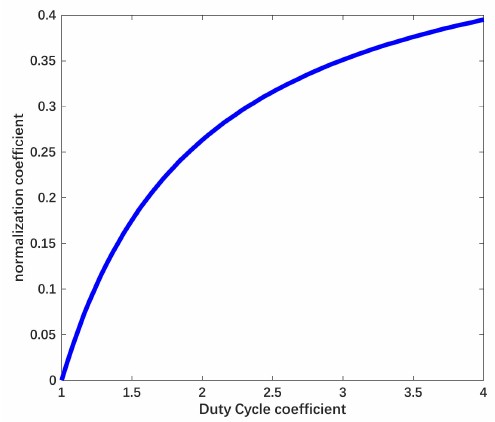
Figure 8. The variation of total electrostatic force with linearly increasing deposited charge in time domain: ( a ) Total electrostatic force under different forms of actuation and the coefficient of duty cycle is set as 2; ( b ) Total electrostatic force under different partition of duty cycle.